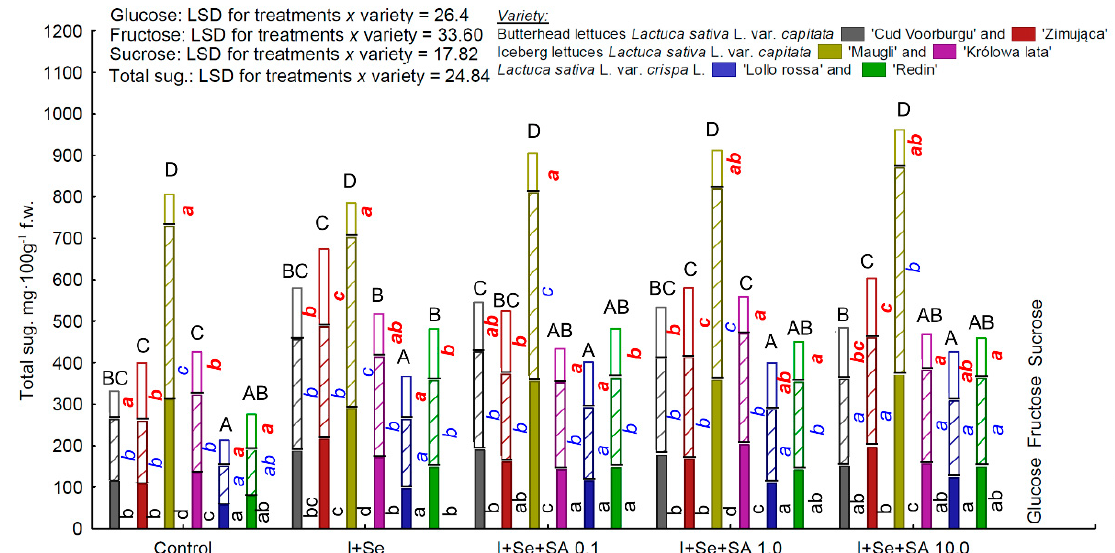
Figure 3. Total sugars in lettuce as sum concentrations of glucose (full gradient), fructose (diagonal lines gradient), and sucrose (empty gradient). Means for cultivars followed by the same letters separately for each treatment (type of nutrient solution) and each kind of sugar are not significantly different at p < 0.05. Determination of homogeneous groups: lowercase black letters for glucose, lowercase blue italic letters for fructose, lowercase red bold italics for sucrose, and capital black letters for total sugars. LSD for interaction “treatments × variety” at p < 0.05. Bars indicate standard errors ( n = 8). f.w.—fresh matter weight.